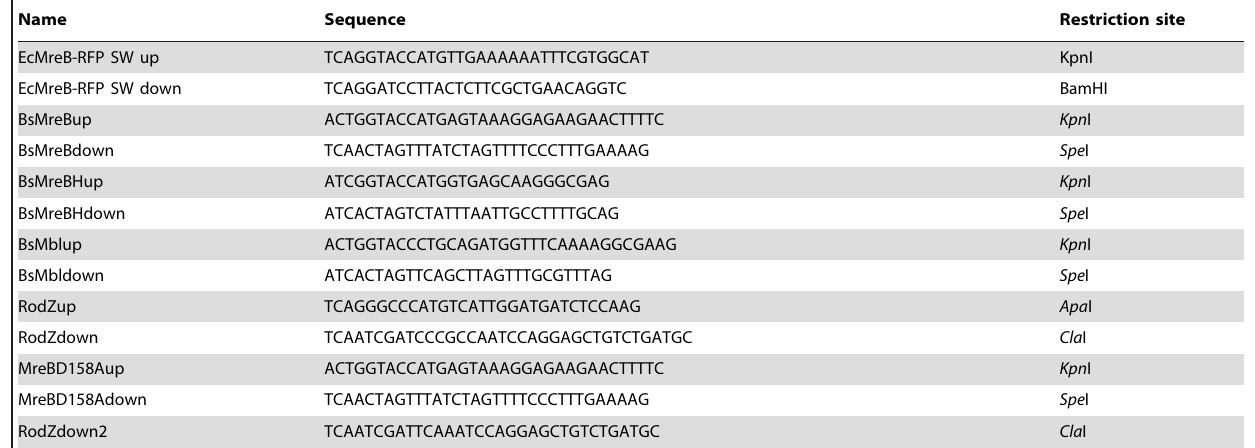
Table 2. Oligonucleotides.